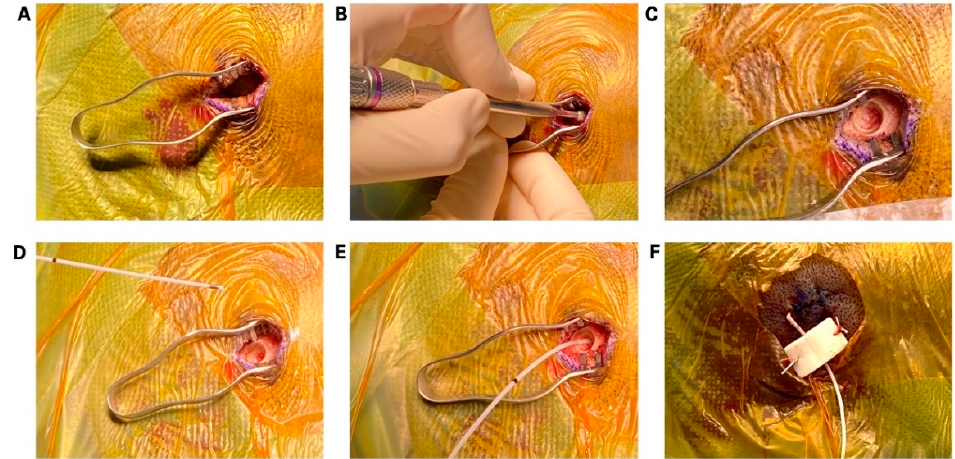
Figure 3. ( A ) step-by-step illustration of the placement of the 1-contact cylindrical electrode (1-CE). A small, approximately 1.5 cm incision is made. ( B , C ) A burr hole is made with a small diamond drill. ( D , E ) Placement of the 1-CE in a flat position between skull and dura. ( F ) Wound closure with fixation of the epidural electrode.